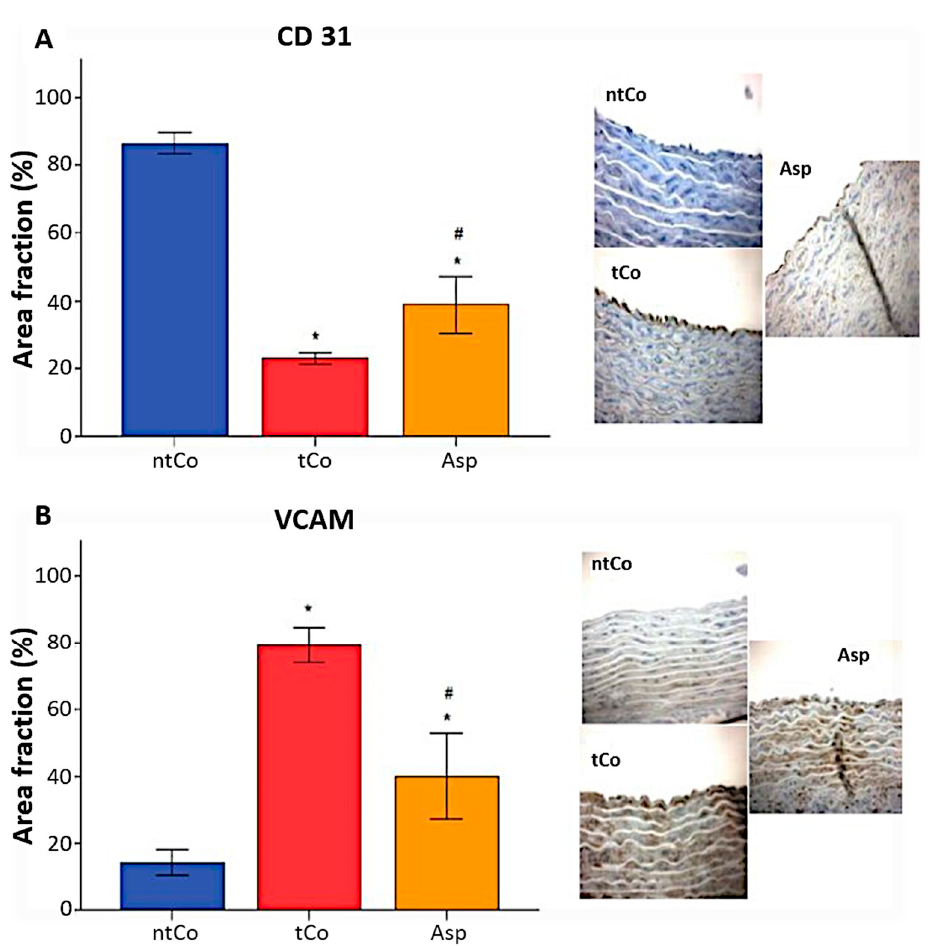
Figure 5. We carried out histomorphological analysis of the endothelium by identifying uninjured and activated endothelial cells. ( A ) CD-31 positive area, reflecting the uninjured endothelium surface was significantly more extensive in the Asp group compared to the tCo group. ( B ) VCAM immunoreactivity was increased after transplantation, which leads to increased leukocyte invasion. Aspirin pretreatment decreased the VCAM positivity of the endothelium. * p < 0.05 vs. ntCo, # p < 0.05 vs. tCo. Magnification: 200×.